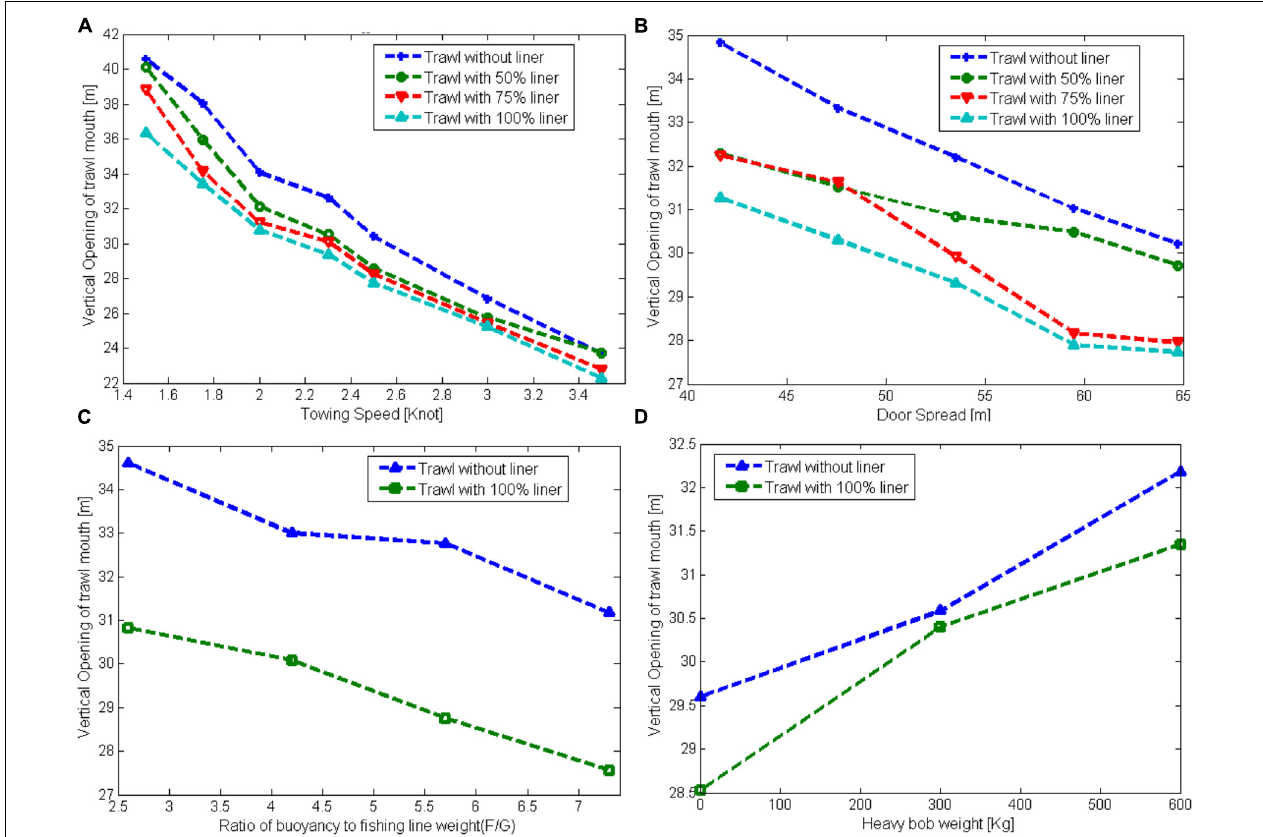
FIGURE 8 | The vertical diameter of the elliptical trawl net mouth shape of different trawls about the (A) towing speed, (B) door spread, (C) ratio of buoyancy to F / G , and (D) heavy bob weight: current data estimated with 95% confidence intervals from the statistical analysis.